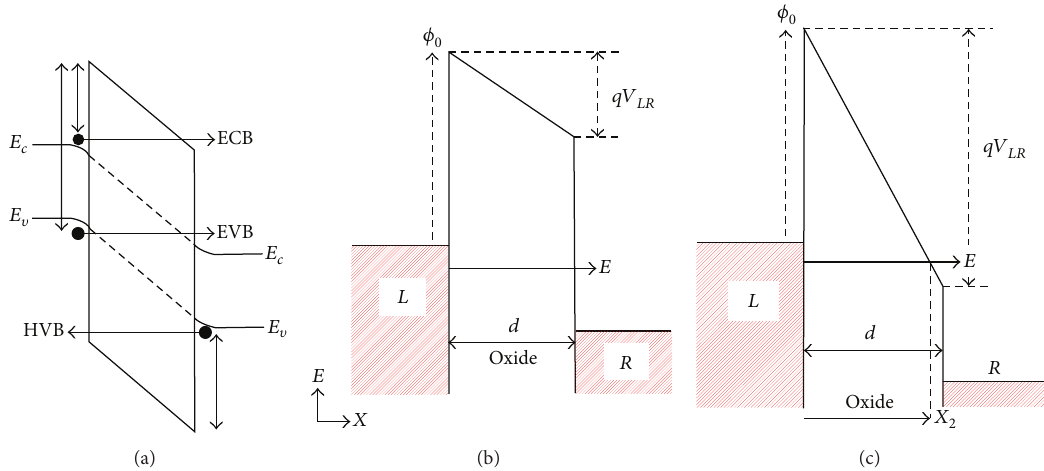
Figure 2: (a) Schematics of the different tunneling processes. Electron from conduction band to conduction band (ECB), electron from valence band to conduction band (EVB), and tunneling from valence band to valence band (HVB) processes. Energy band diagram for the tunneling processes under polarization. (b) If the incident electron energy ( 𝐸 ) is less than the modified energy barrier ( 𝑞𝜙 0 − 𝑞𝑉 𝐿𝑅 ) we use a direct tunnel expression. (c) If the incident electron energy ( 𝐸 ) is greater than the modified energy barrier ( 𝑞𝜙 0 − 𝑞𝑉 𝐿𝑅 ), we use a Fowler- Nordheim expression. These expressions depend on the incident electron energy but also depend on the polarization